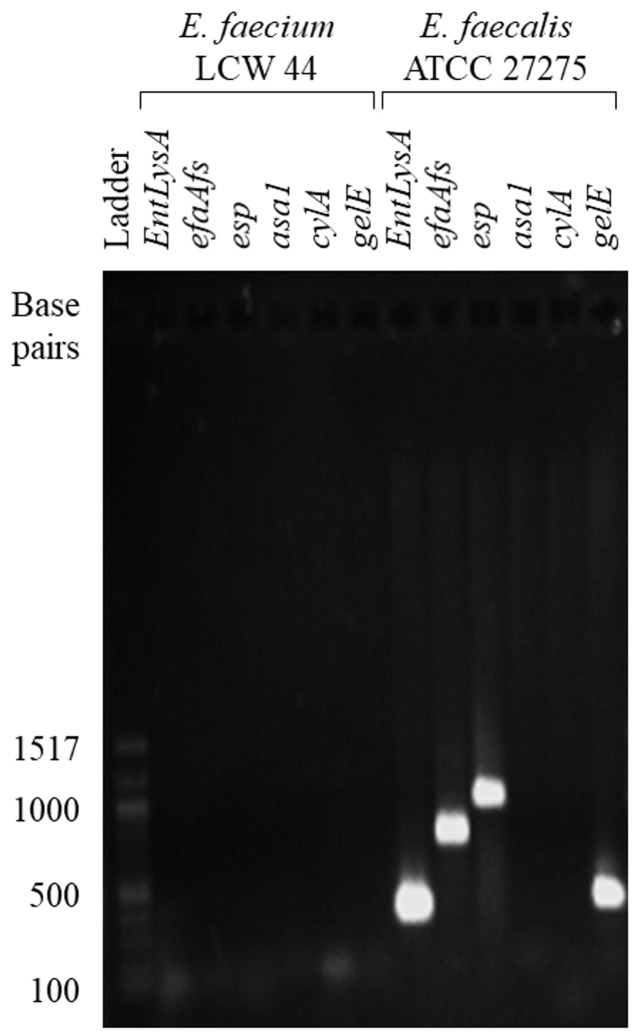
PCR fragments generated from total genome of E. faecium LCW 44 and E. faecalis ATCC 27275 using oligonucleotide primers specific for enterolysin A (EntLysA), cell wall adhesin (efaAfs), surface protein involved in immune evasion (esp), aggregation substance (asa1), cytolysin (cylA) and gelatinase (gelE), resolved by electrophoresis on agarose gel.